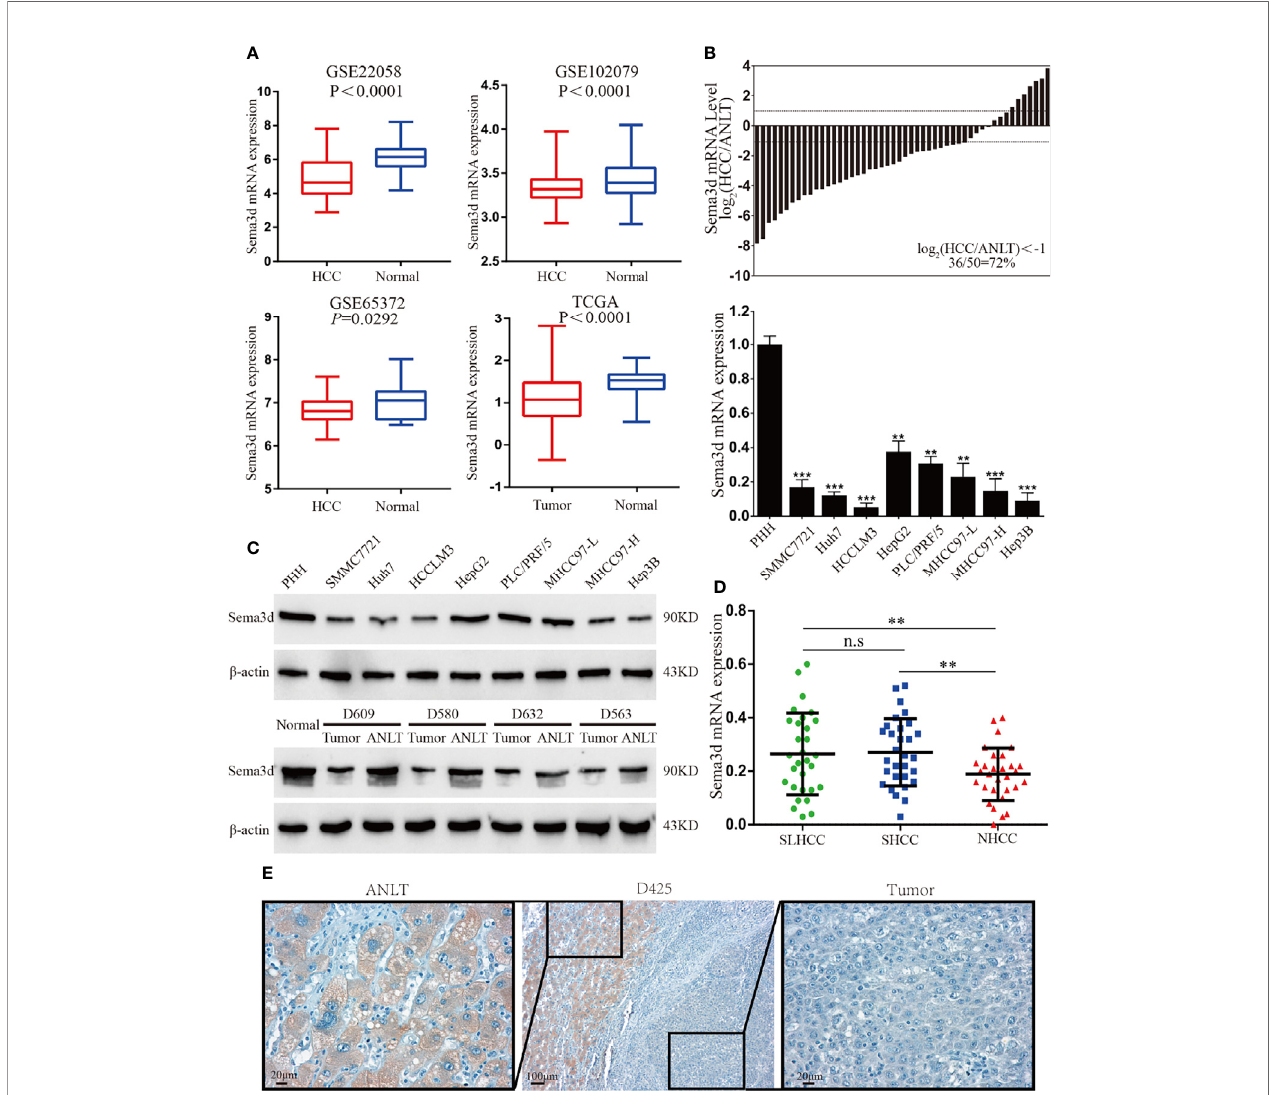
FIGURE 1 | Sema3d is downregulated in HCC cell lines and tissues. (A) Sema3d expression in Gene Expression Omnibus (GEO) datasets (GSE22058, GSE102079, GSE56372) and TCGA database. (B) Sema3d mRNA expression level was detected by qRT-PCR in 50 HCC and paired ANLT samples (upper panel), 8 HCC cell lines, and primary human hepatocytes (PHHs) (lower panel). (C) Sema3d protein expression was examined by Western blot in PHHs and HCC cell lines, representative normal liver tissue, paired HCC tissues, and ANLTs. (D) Sema3d mRNA expression in HCC tissues of 3 clinical subtypes (SLHCC, SHCC, and NHCC) was detected by qRT- PCR. (E) Representative IHC images of Sema3d expression in HCC tissues and corresponding ANLTs. ** p < 0.01; *** p < 0.001. n.s, no signi fi